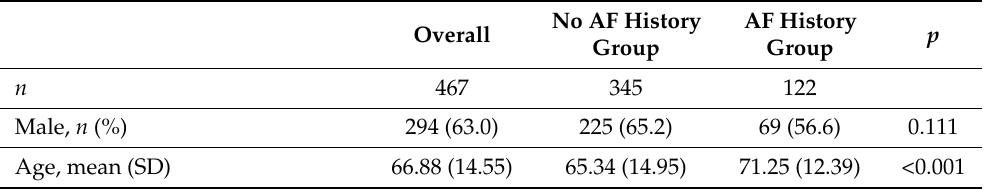
Table 1. Characteristics of the overall study population and differences between the two groups according to the presence or not of pre-existing AF.